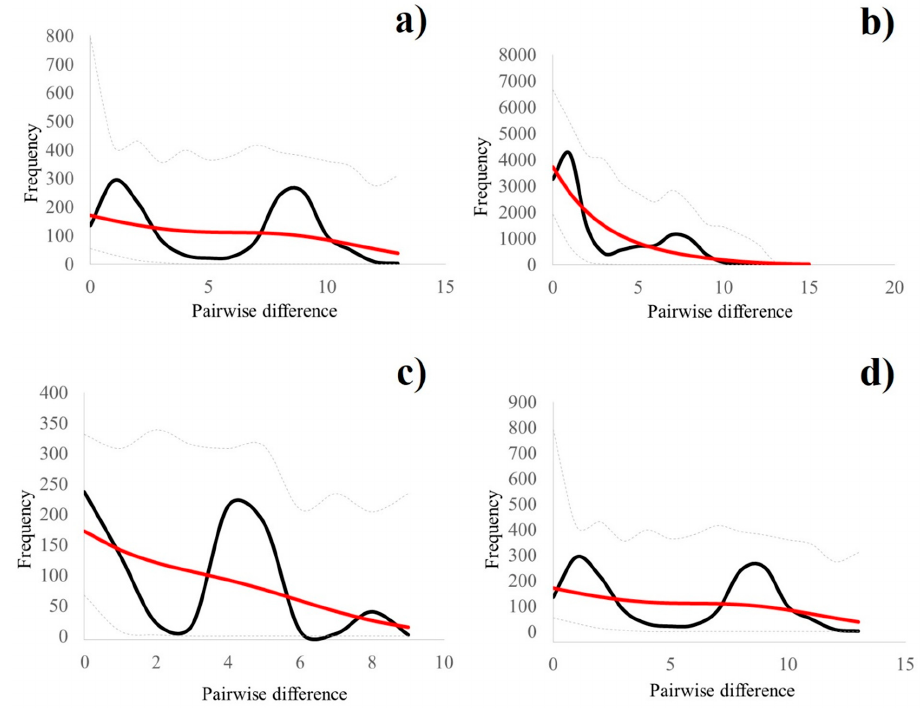
Figure 4. Mismatch distributions of Anodonta anatina lineages based on the mitochondrial COI gene. ( a ) IBER lineage (N = 56 sequences; Raggedness P = 0.29; Model (SSD) P = 0.11); ( b ) EUR lineage (N = 168 sequences; Raggedness P = 0.71; Model (SSD) P = 0.72); ( c ) ITAL lineage (N = 42 sequences; Raggedness P = 0.18; Model (SSD) P = 0.12); ( d ) AZOV lineage (N = 58 sequences; Raggedness P = 0.07; Model (SSD) P = 0.09).